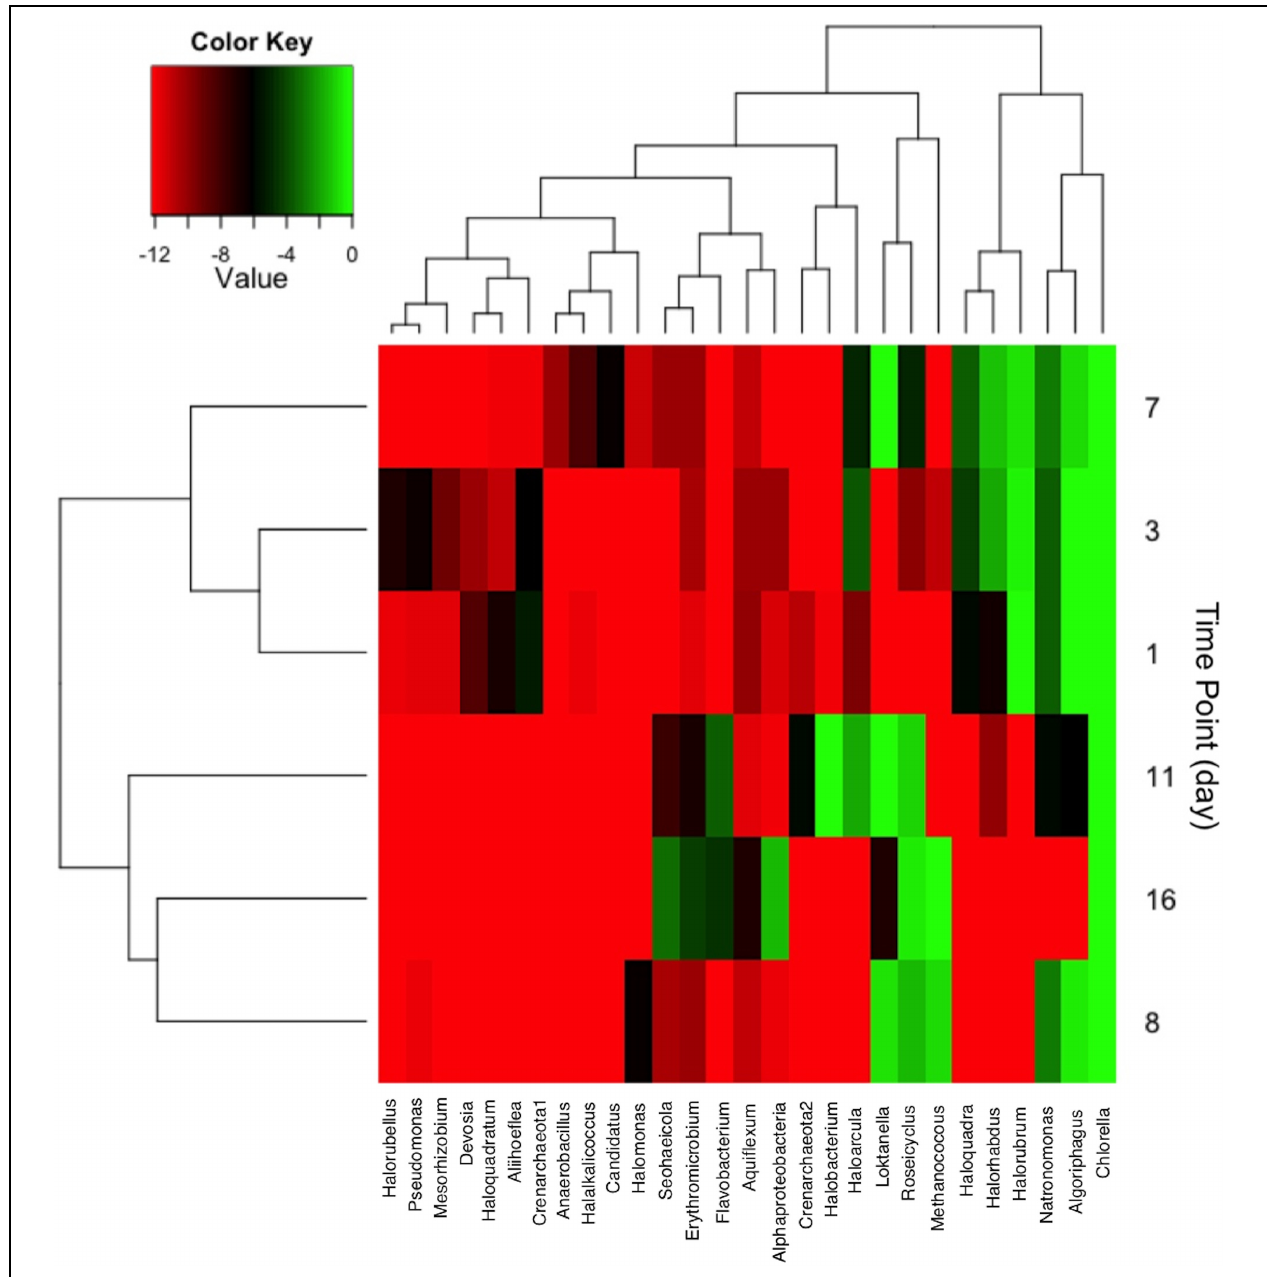
FIGURE 6 | Heat map showing taxa with greater than 2% relative abundance at each sampling time point. Taxa co-occurrence and each time points were correlated and clustered according to relatedness as shown in the